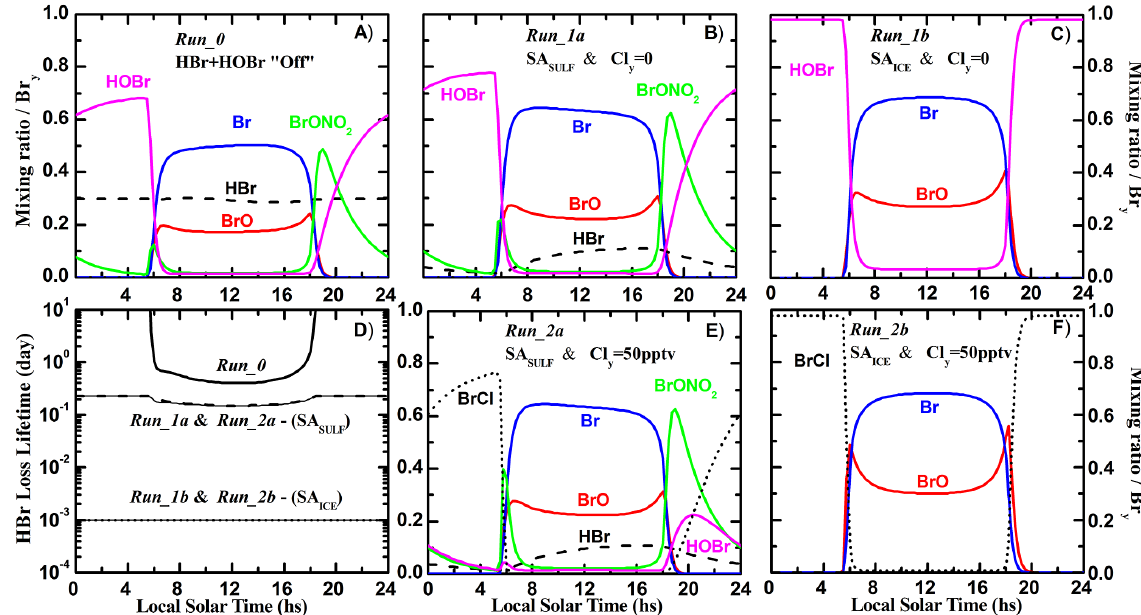
Figure 7. Calculated abundance of inorganic bromine species as a function of local solar time for different sensitivity simulations: (a) Run_0 (SA SULF ; γ HOBr + HBr = 0; Cl y = 0); (b) Run_1a (SA SULF ; γ HOBr + HBr = 0 . 25; Cl y = 0); (c) Run_1b (SA ICE ; γ HOBr + HBr = 0 . 1; Cl y = 0); (d) photochemical lifetime of HBr for all five sensitivity simulations; (e) Run_2a (SA SULF ; γ HOBr + HBr = 0 . 25; Cl y = 50pptv);